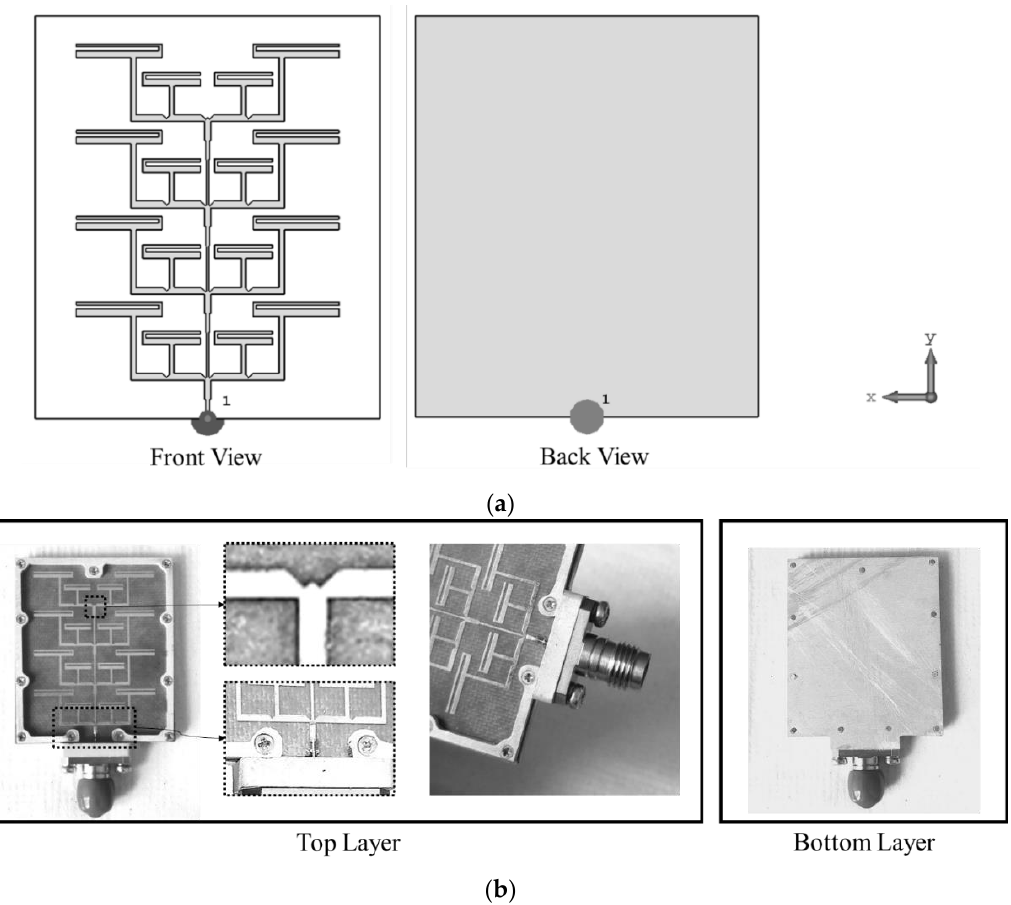
Figure 1. Array antenna for wireless terminals. ( a ) Computer model. ( b ) Manufactured model.